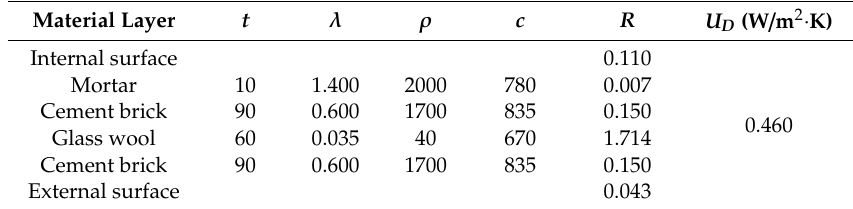
Table 1. Stratigraphies and thermophysical properties of the test wall.